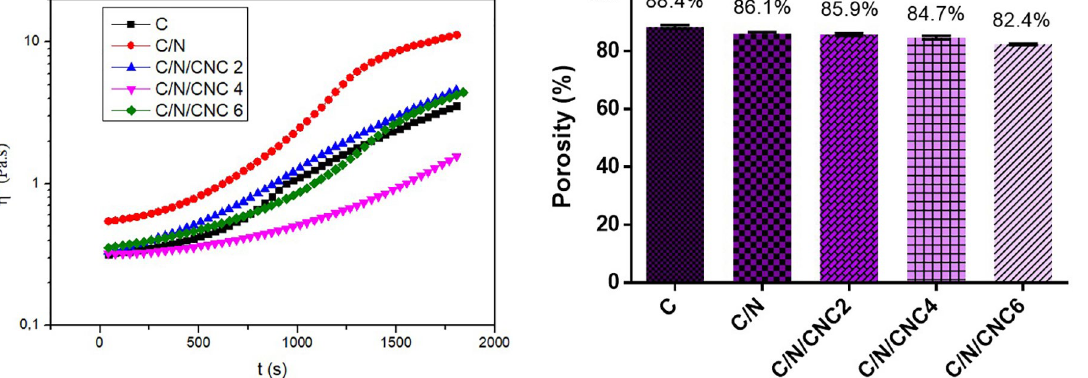
Figure 3. Graph of the complex viscosity (η*) as a function of time (t) of the hydrogels.